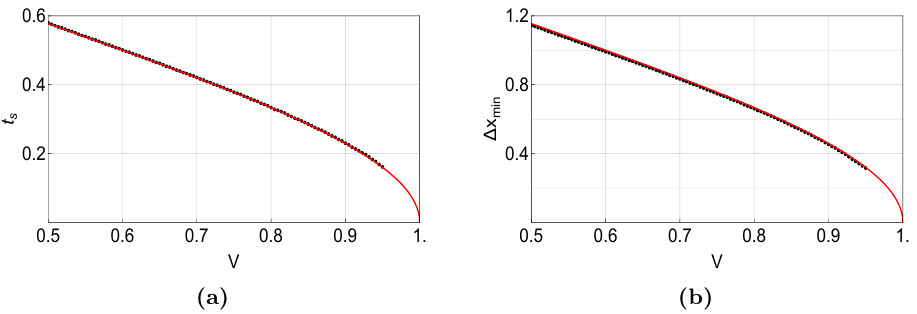
Figure 19 . The cases of di(cid:11)erent velocities V . (a) Characteristic time t s and (b) the minimum size (cid:1) x min . Dots represent numerical data whereas solid curves stand for expressions t s = and (cid:1) x min = 2 t s